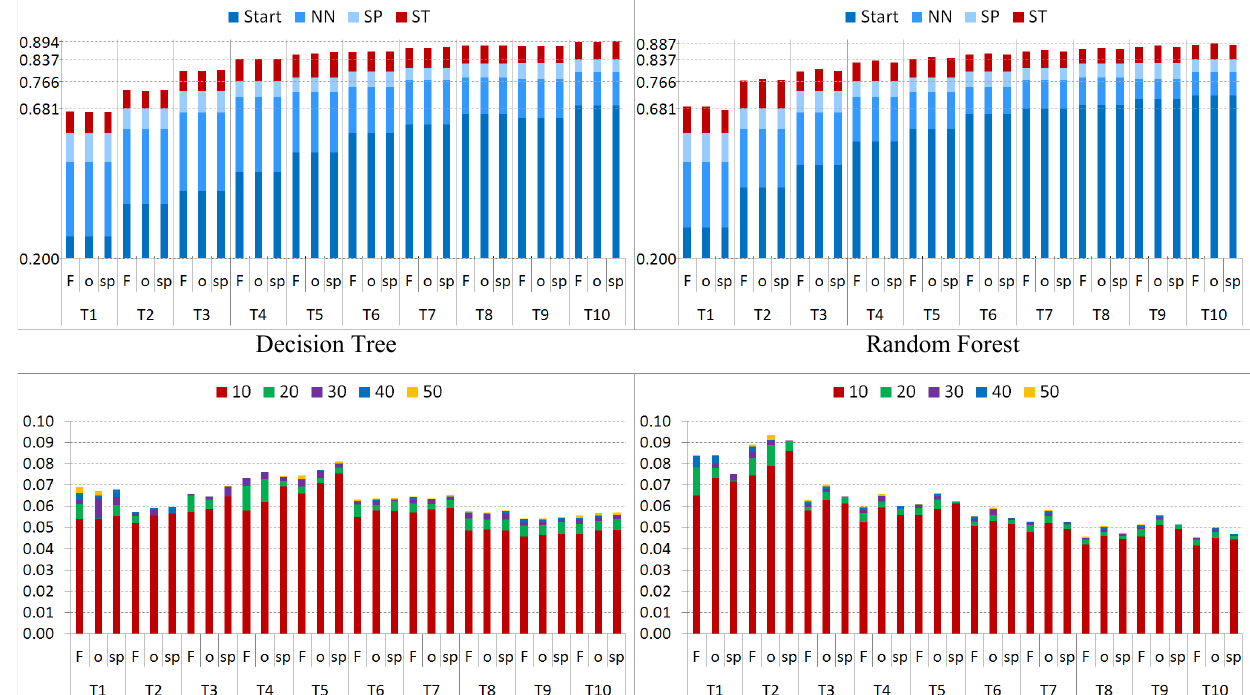
using the three i